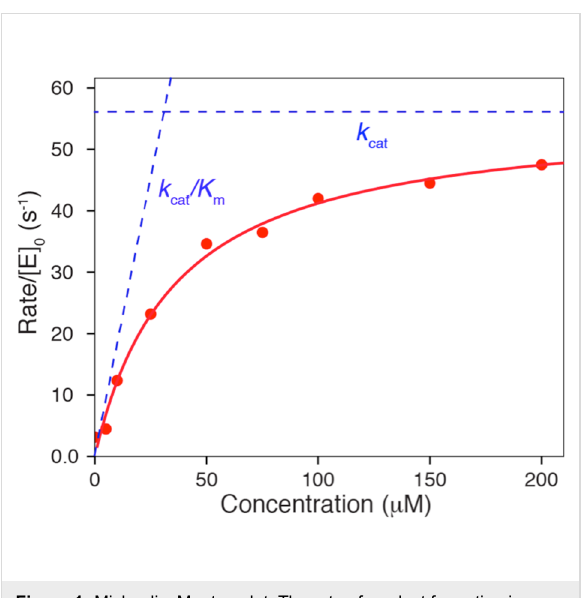
Figure 1: Michaelis–Menten plot. The rate of product formation is plotted versus substrate concentration and fit to a hyperbola. The dashed lines illustrate k cat / K m (slope) and k cat . The intersection of the two lines gives the substrate concentration at which k cat / K m [S] i = k cat , so [S] i = k cat /( k cat / K m ) = K m